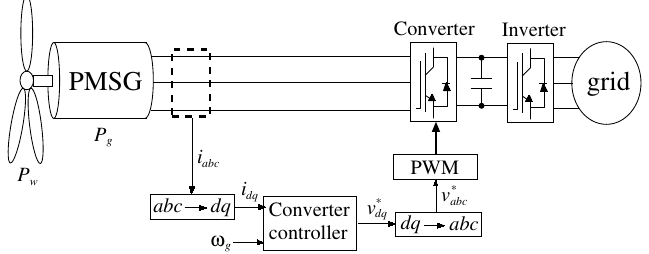
Figure 1. Configuration of power conversion control system of permanent magnet synchronous generator (PMSG) wind